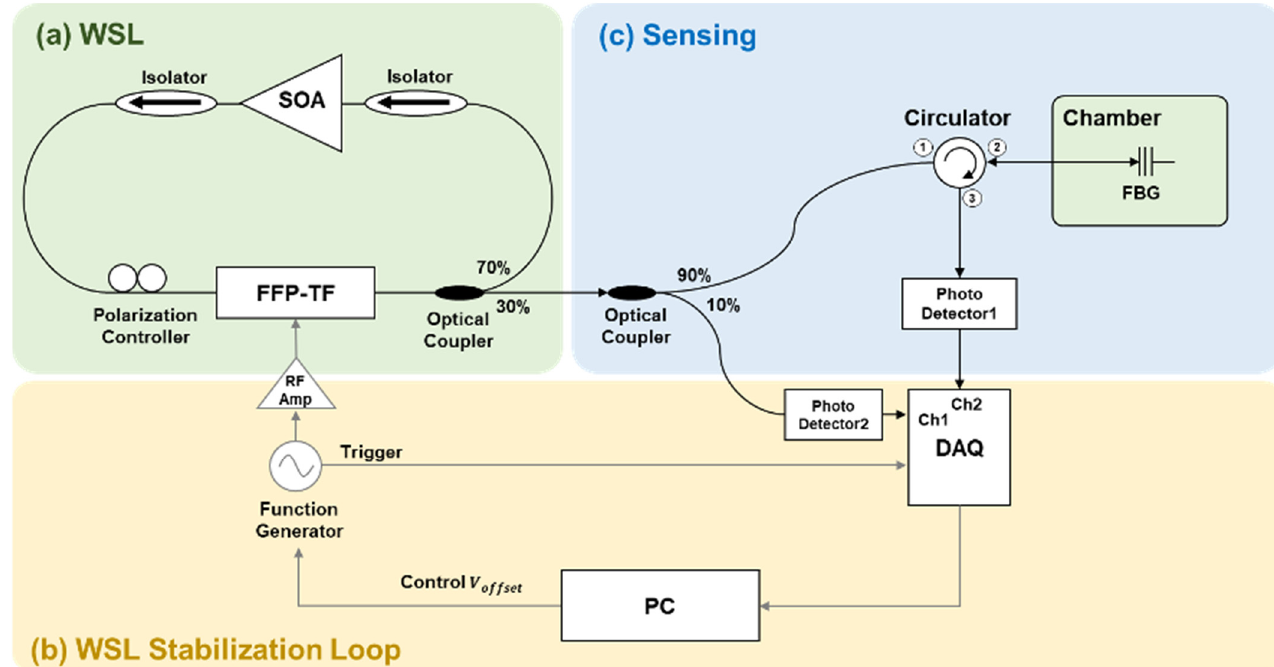
Figure 3. Schematic diagram for stabilizing the wavelength variation in WSL: ( a ) experimental setup of a WSL based on a FFP-TF; ( b ) structure of the closed-loop control; and ( c ) experimental setup for measuring the temperature change signal by placing the FBG in a temperature chamber. (WSL: wavelength-swept laser; SOA: semiconductor optical amplifier; FFP-TF: fiber Fabry–Pérot tunable filter; DAQ: data acquisition board; PC: personal computer; FBG: fiber Bragg grating).